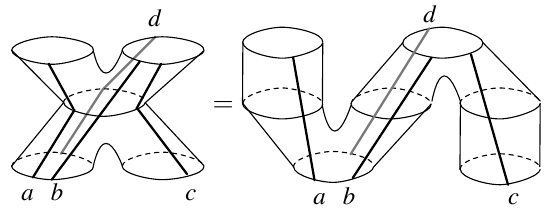
Figure 51 . One possible topology change. The line d is on the back side of the